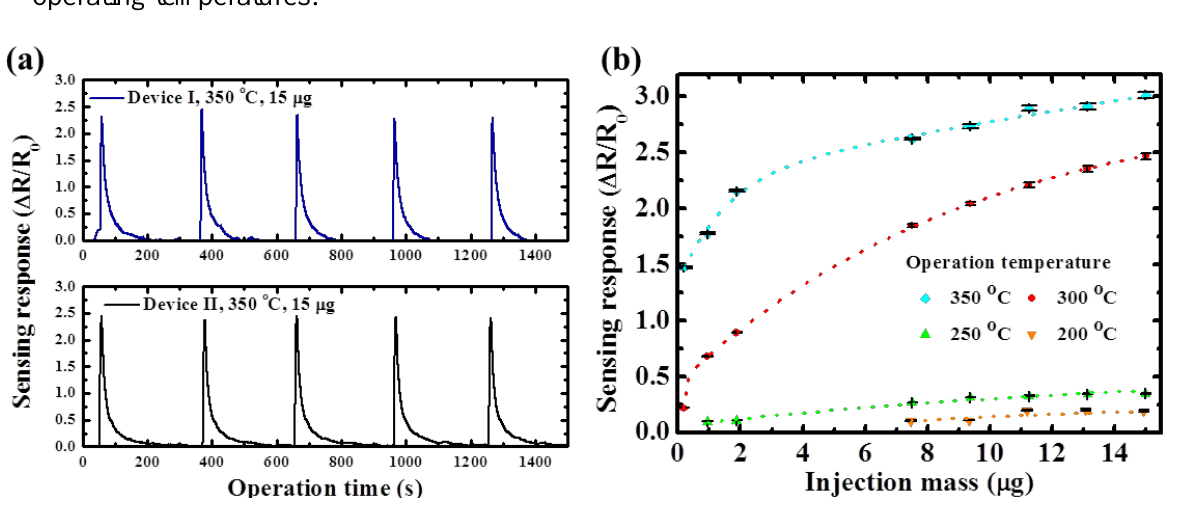
nanowire sensors under various 2